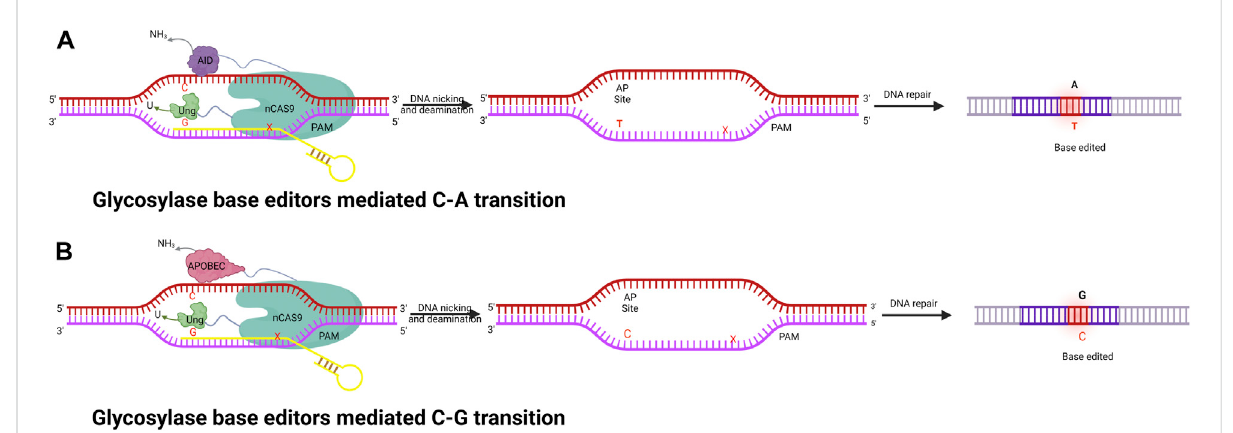
FIGURE 4 Illustration of fused nCas9, AID, and UNG enzyme complexes to perform a series of functions, including speci fi c DNA binding, cleaving of the amine group from C, and creating AP sites followed by cellular repair to achieve speci fi c base editing. (A) Glycosylase base editor – mediated C-A transition. (B) Glycosylase base editor – mediated C-G